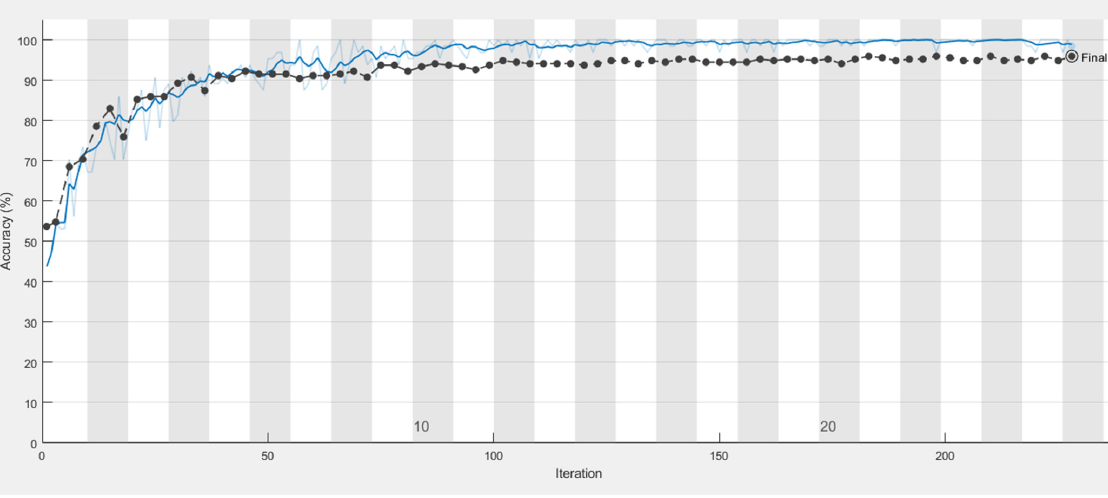
Figure 14. Loss process of the model in classifying restorations, with the black and orange lines illustrating the loss of the test set and training set, respectively. According to Tables 10 and 11, the parameter MiniBatchSize of Vgg19 was different from the other networks, because Vgg19 needs a large capacity and, thus, more memory in the GPU. Table 10. Network comparison for caries. Network Comparison for Caries AlexNet